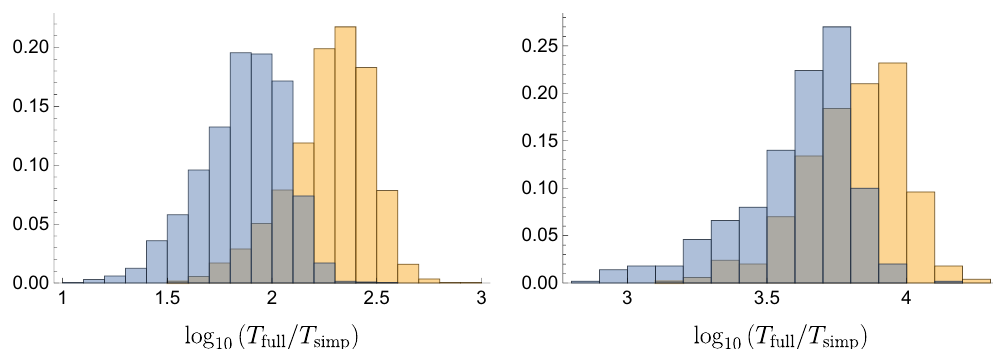
Figure 6 . Gain in performance for 2-vev (left panel) and 3-vev (right panel) manifolds, using the minimisation procedure described in section 3.2 (yellow bars) and its improved version (blue bars), compared to a full-fledged numerical minimisation.